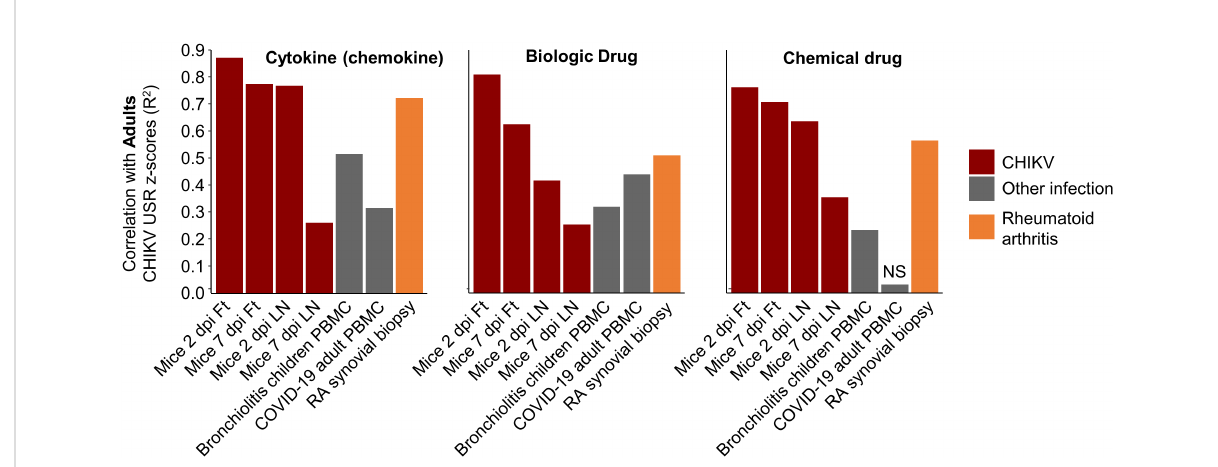
FIGURE 6 Pearson correlations for IPA USRs with other infections and rheumatoid arthritis. The DEGs from whole blood of CHIKV-infected Adults were analyzed by IPA to provide z-scores for signi fi cant USRs and USRs for (Molecule type) Cytokine, Biologic drug and Chemical drug. These z-scores were compared by Pearson correlations with z-scores from peripheral blood mononuclear cells (PBMC) from children with bronchiolitis and Adults infected with SARS-CoV-2, as well as synovial biopsies from rheumatoid arthritis (RA) patients. Coef fi cients of determination (r 2 ) are